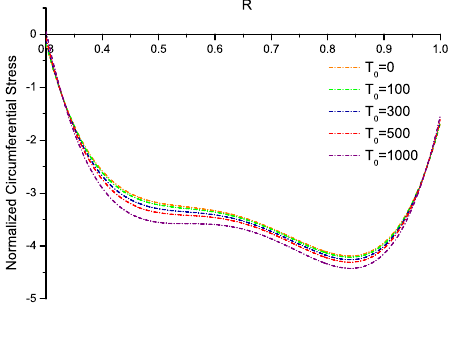
Figure 7: Normalized circumferential stress distribution in FGM hollow cylinder with different values of T 0